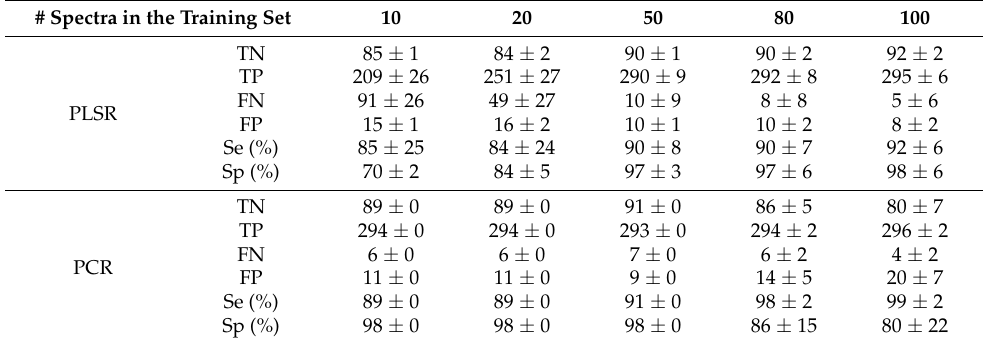
Table 1. Classification results for Partial Least Squares Regression (PLSR) and Principal Component Regression (PCR) for different test sets. In the yellow boxes are reported the resulting Se and Sp as calculated from Equations (1) and